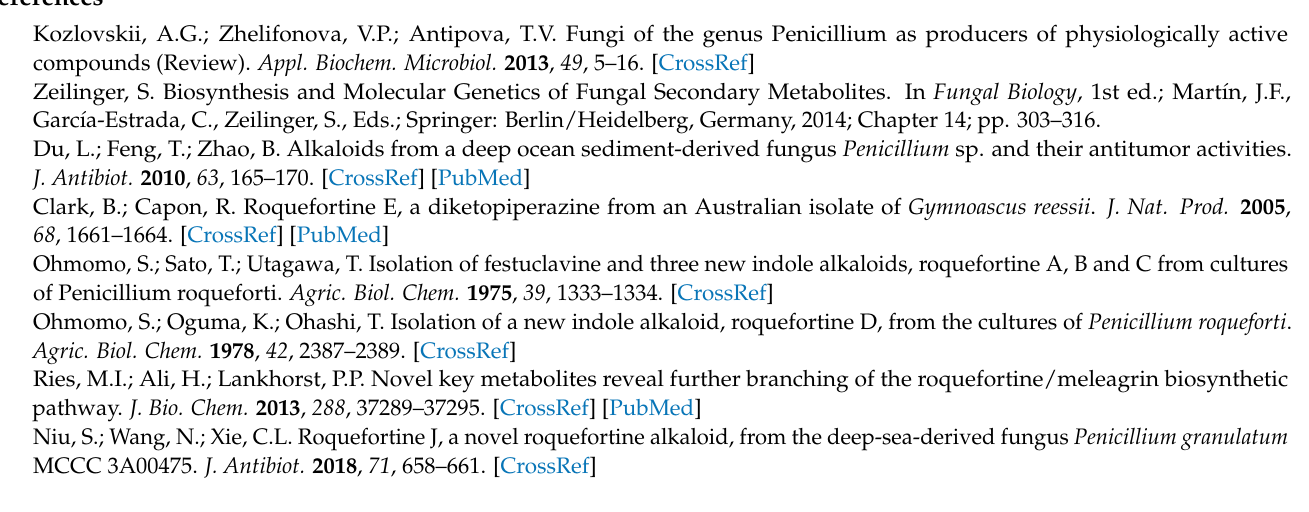
DMSO; Figure S4: 13 C(125MHz)-NMR spectrum of compound 1 in DMSO; Figure S5: 1 H(500MHz)- NMR spectrum of compound 2 in DMSO; Figure S6: 13 C(125MHz)-NMR spectrum of compound 2 in DMSO; Table S1: 1 H and 13 C NMR Data for Compounds 1 and 2 ( 1 H 500MHz, 13 C 150 MHz, DMSO-d6, TMS, δ